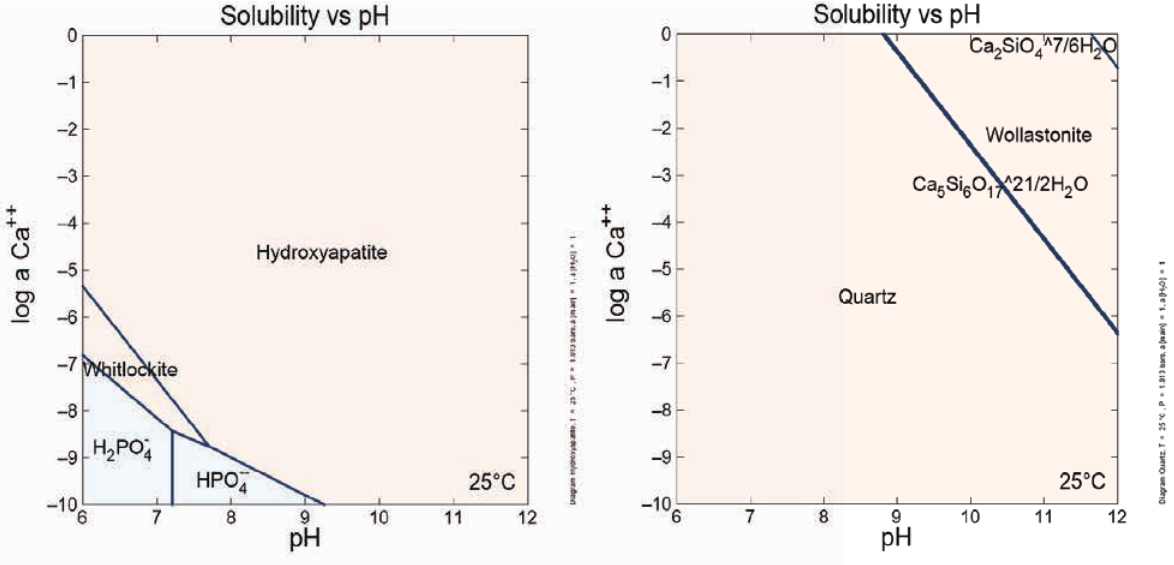
Figure 3: (a) Left: Presence of minerals in sediments without incorporation of wollastonite; (b) Right: Presence of minerals in sediments with incorporation of wollastonite. T = 25°C, P = 1.013